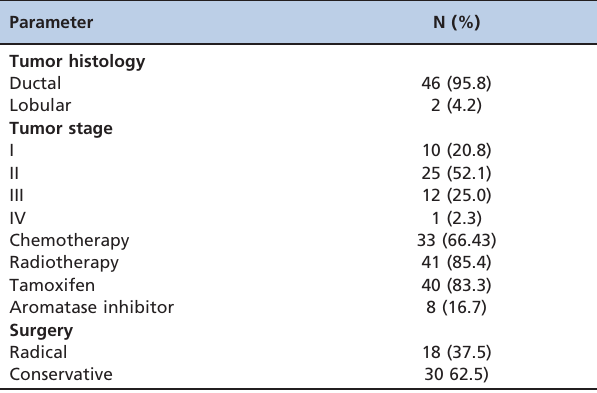
Table 1 - Medical parameters of breast cancer survivors. Parameter N (%)